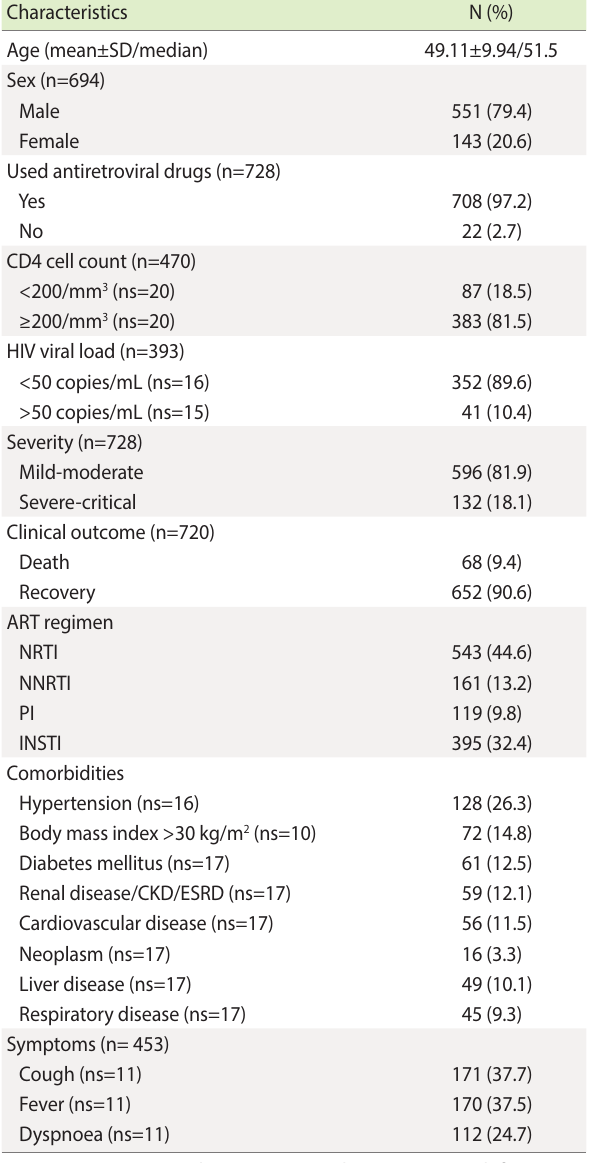
Table 4. Demographic and clinical characteristics of COVID-19 in- fection in people living with HIV included in the reviewed studies